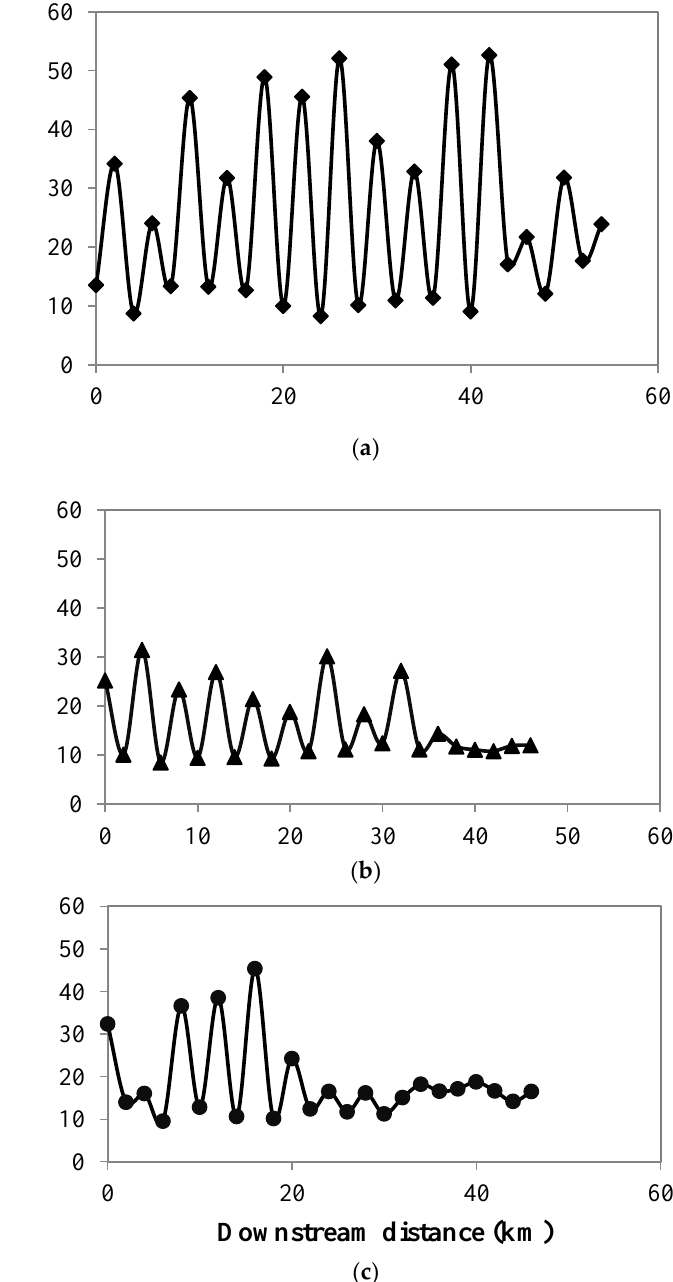
Figure 5. Variation of predicted bed shear stress with distance along the river reaches: Crowsnest River (( a ) Flow rate = 2.65 m 3 /s; Manning’s n = 0.070), Castle River (( b ) Flow rate = 4 m 3 /s, Manning’s n = 0.070), Oldman River (( c ) Flow rate = 5 m 3 /s, Manning’s n = 0.070).